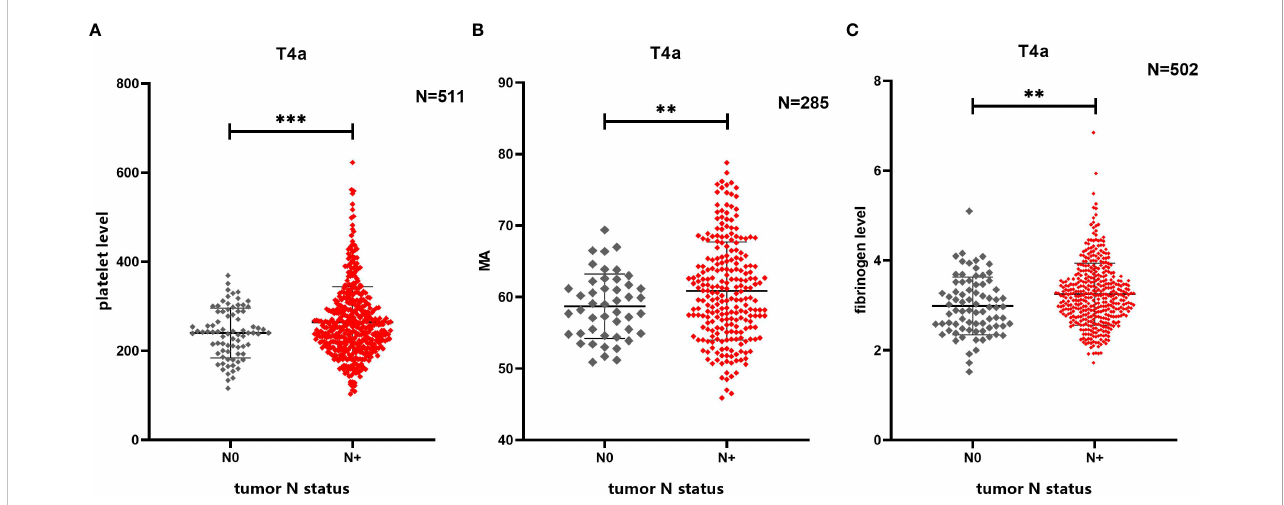
FIGURE 2 Comparison of differences in multiple coagulation-related factors according to presence or absence of lymph node metastasis. (A) Lymph node metastasis in patients with gastric cancer is related to platelet level. (B) Lymph node metastasis in patients with gastric cancer is related to MA. (C) Lymph node metastasis in patients with gastric cancer is related to fi brinogen level. ** 0.001 ≤ P<0.01, *** P<0.001